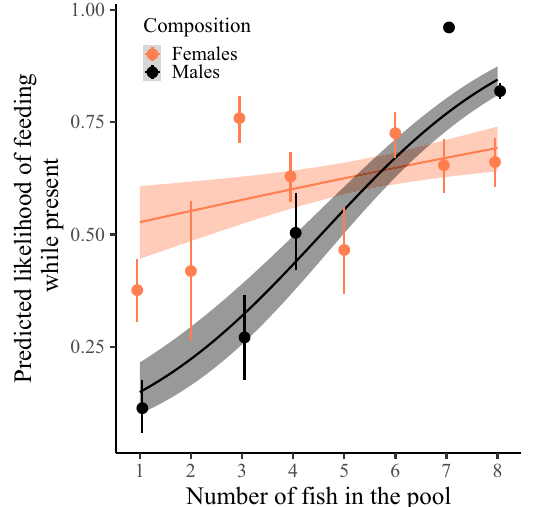
Fig. 4 Number of bites per individual as a function of the number of fi sh in the pool. Dots with bars represent the mean ± 95% con fi dence interval (CI) summary statistics for each sex (female/male = orange/black) and fi sh number (CI obtained from 1000 bootstraps). Grouping of the data was conducted for graphical purposes only; analyses were conducted on the level of individuals ( n = 265) with the number of fi sh in the pool as a continuous variable (Table 4). Note that there were no batches with two, fi ve or six males (Supplementary Table 2). Regression lines show the predicted fi nal model values. Shaded areas around the lines re fl ect 95% CI. A slight horizontal position dodge was added to reduce overlap.